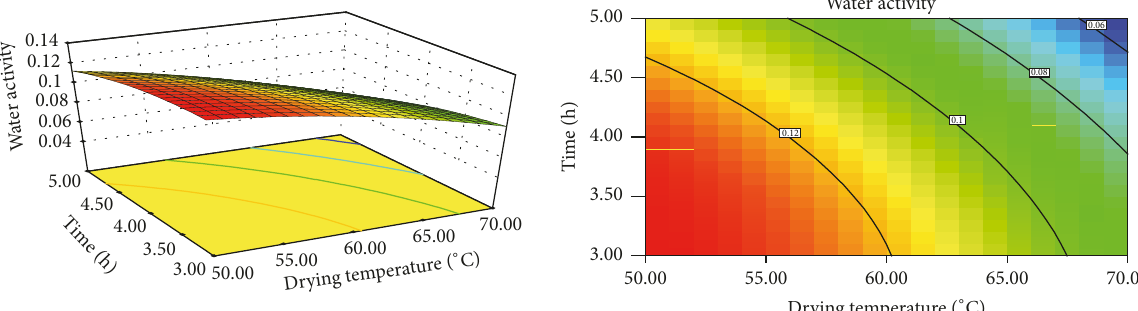
Figure 3: 3D response surface and contour plots for the effect of drying temperature and time on water activity of SLS.